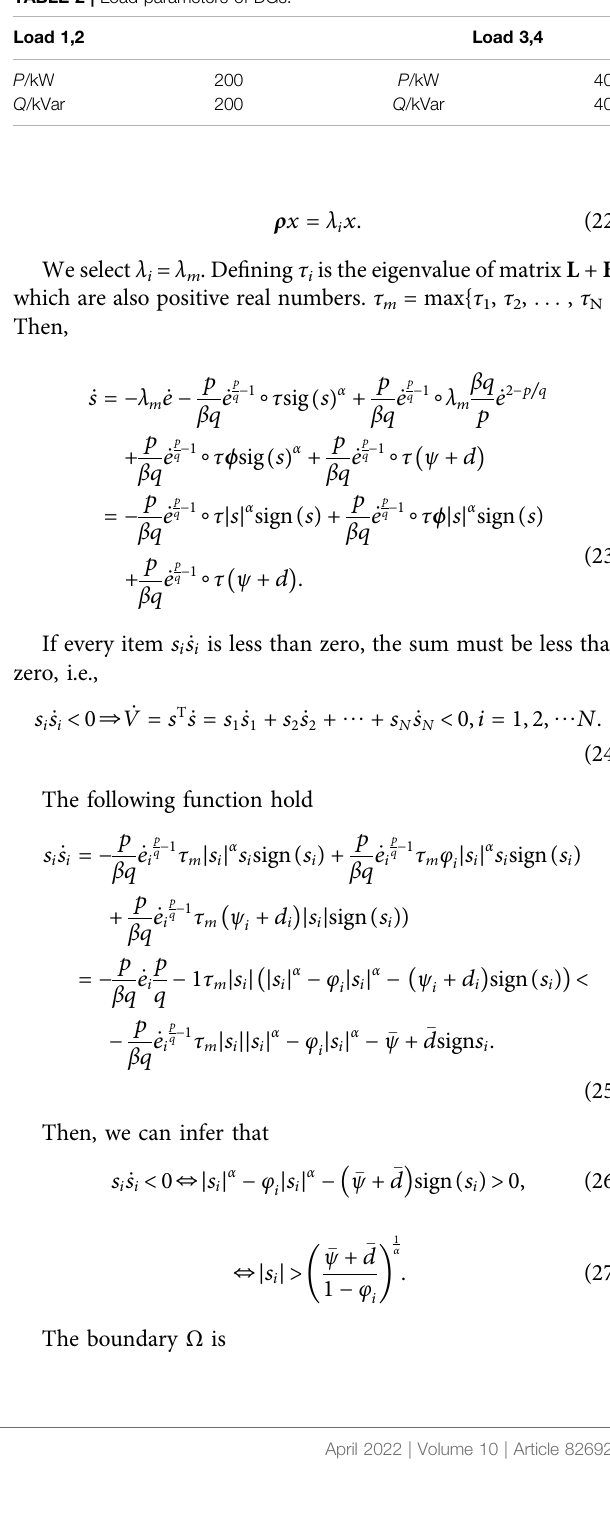
TABLE 2 | Load parameters of